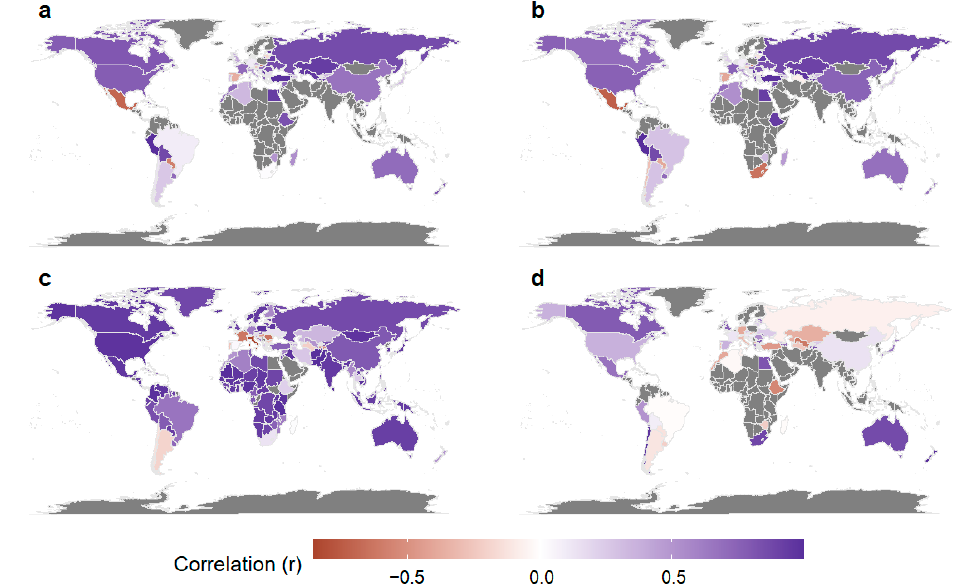
Figure 7. Pearson correlation coefficients between wine industry factors for each country, including correlations between production and consumption ( a ); production and consumption per capita ( b ); consumption and imports ( c ); and production and exports ( d ).